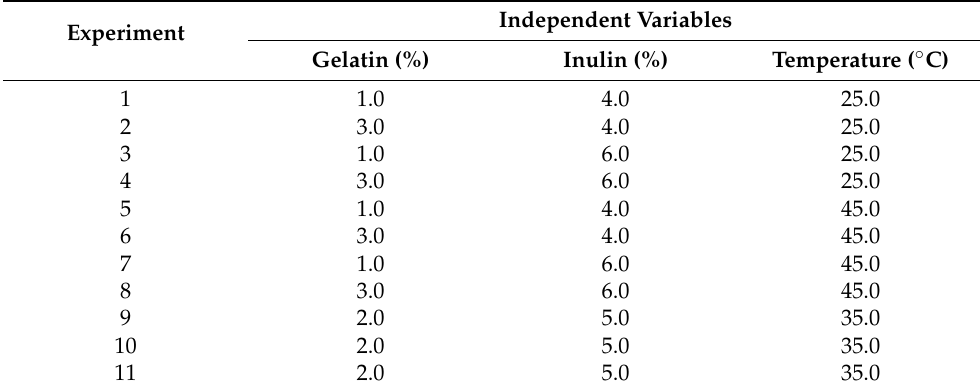
Table 1. Matrix of the full 2 3 experimental plan with three replicates at the central point with actual values of the independent